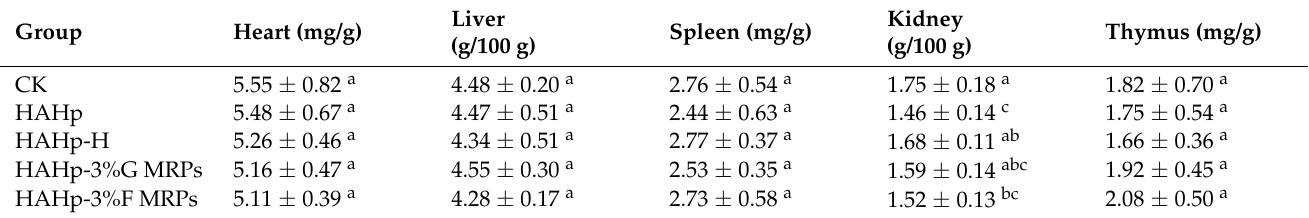
Table 2. Organ indices of the heart, liver, spleen, kidney, and thymus compared among all of the tested groups after 30 days of oral gavage ( n = 7 per